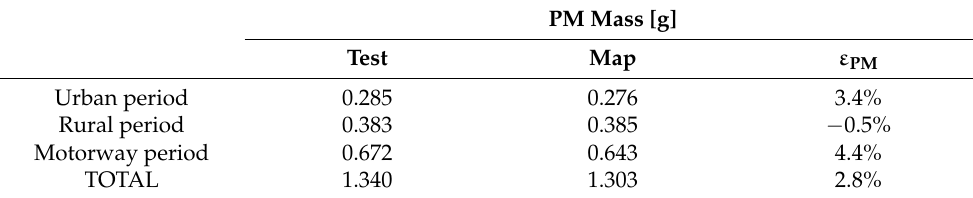
Table 8. PM mass emissions from RDE 1 versus map